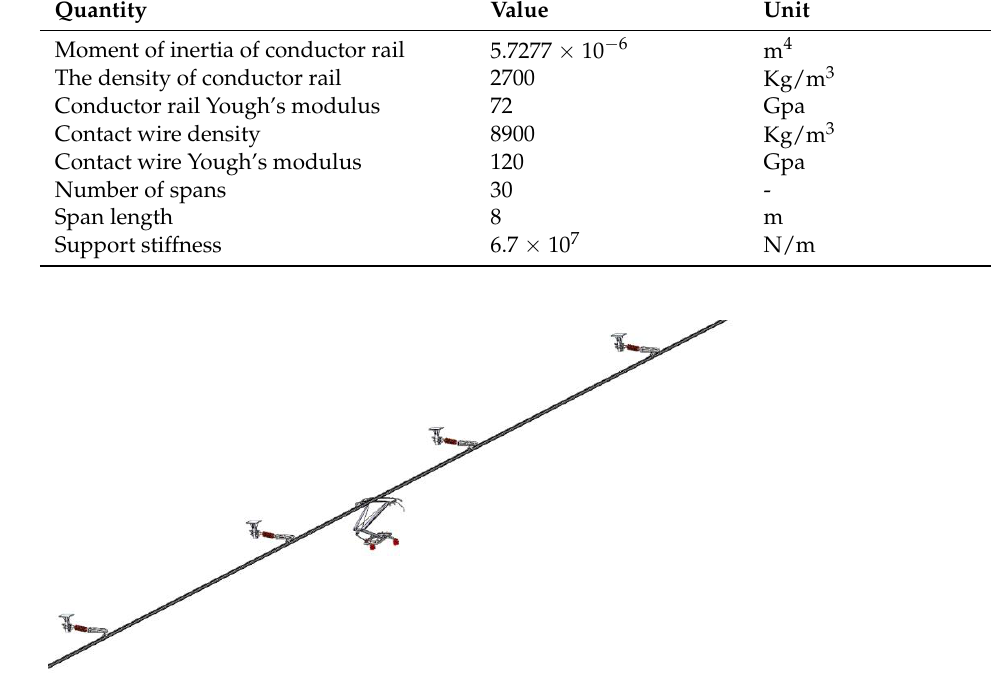
Figure 10. Visualized pantograph-rigid catenary model used in dynamic simulation.